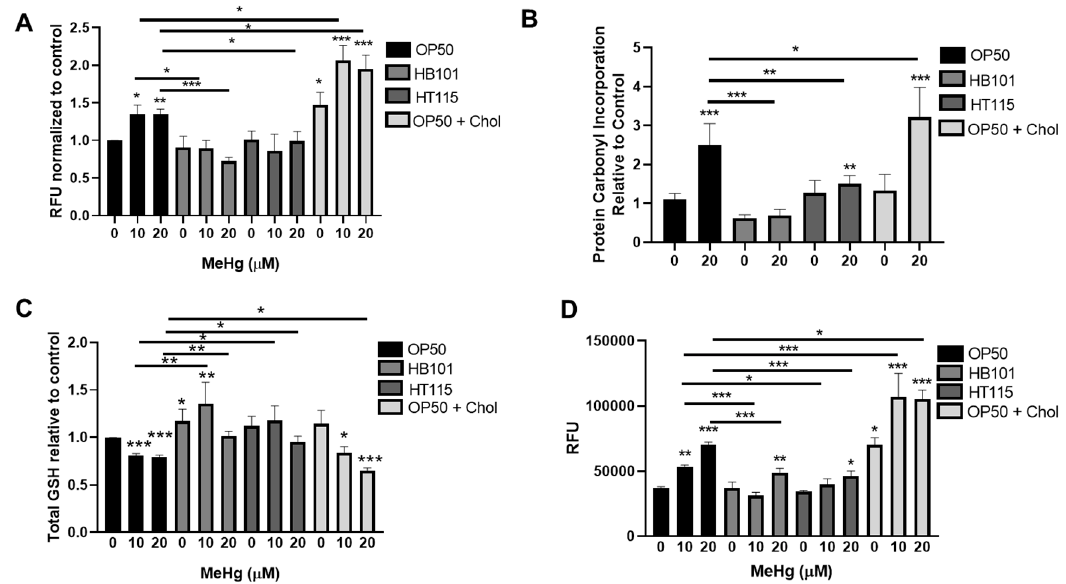
Figure 8. Diet affects MeHg-induced oxidative stress. Worms were treated with MeHg for 30 min and placed on agar plates spread with either OP50, HB101, Ht115, or OP50 supplemented with cholesterol. Measures of oxidative stress were assessed 24 h after MeHg treatment. ( A ) ROS levels were measured through DCFDA fluorescence. Data are expressed as mean fluorescence ± SEM for 6 independent experiments ( B ) Protein carbonyl levels were measured and normalized to protein content. Data are expressed as means ± SEM from 5 independent experiments. ( C ) Total GSH levels were measured and normalized to protein content. Data are expressed as mean ± SEM from five independent experiments. ( D ) Quantification of GFP fluorescence of VP596 transgenic worms expressing GFP under the gst-4 promoter. Data are expressed as means fluorescence ± SEM from 5 independent experiments. * p < 0.05, ** p < 0.01, *** p < 0.001 as compared with untreated, OP50-fed control. Horizontal bars represent comparisons between Hg-treated worms fed different diets.